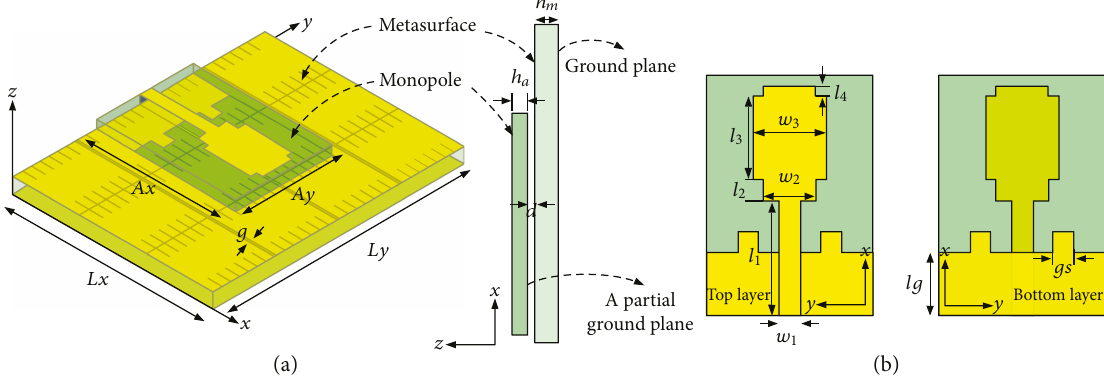
Figure 1: (a) Con fi guration of the PSMS antenna. (b) Top and bottom views of the monopole layer. The optimized dimensions are Ax = 24 , Ay = 16 , Lx = 33 , Ly = 41 6 , g = 33 , h millimeters.